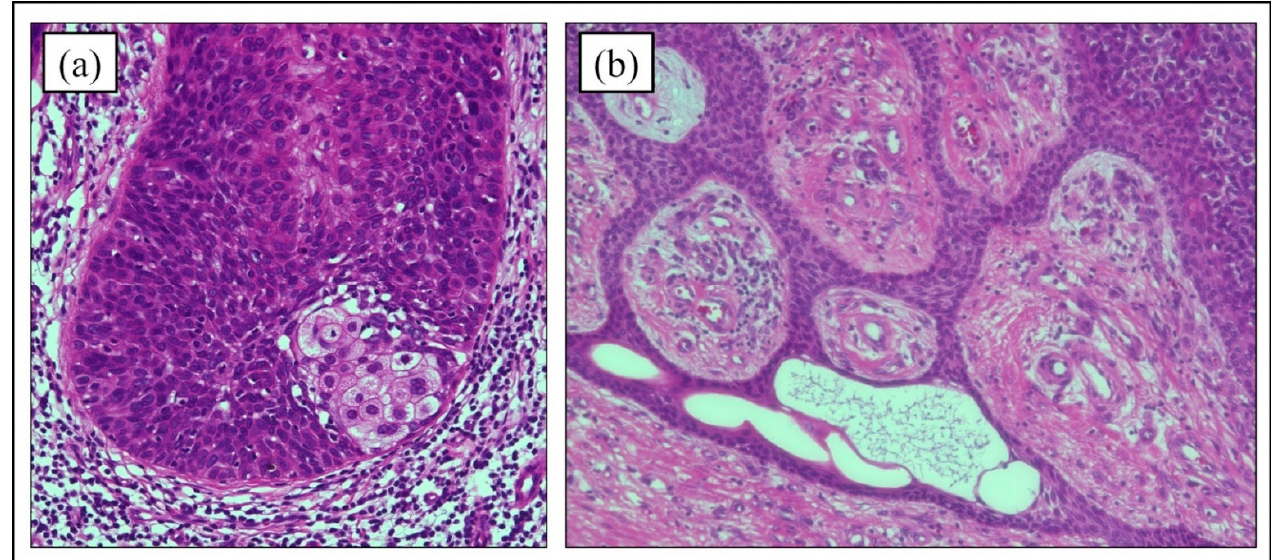
Figure 2. Histopathological findings of comedo necrosis. ( a , b ) Clusters form irregular nests of vari- ous sizes in the intraepidermal. The large nests are accompanied by many comedo necroses. (He- matoxylin and eosin stain; ( a ) original magnification ×20, ( b ) original magnification ×200).